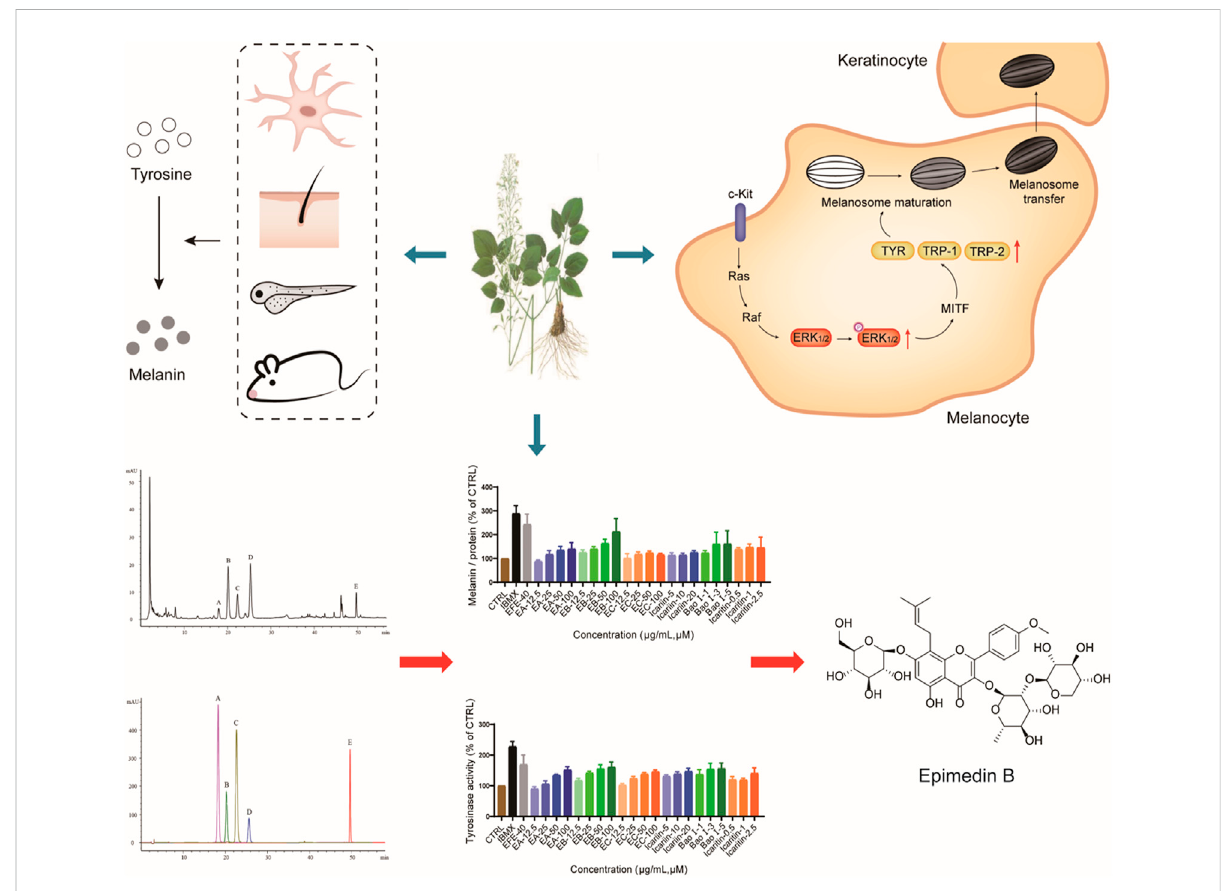
FIGURE 10 EFE can induce pigmentation in vivo and in vitro from multi-aspects, including melanin production, melanosome increase, maturation, and transport/transfer to keratinocyte. The melanogenic mechanism is de fi ned by promoting tyrosinase activity, upregulating the expression of tyrosinase families by activating MAPK/ERK1/2 signal pathway. Also, EB is determined as an important melanogenic